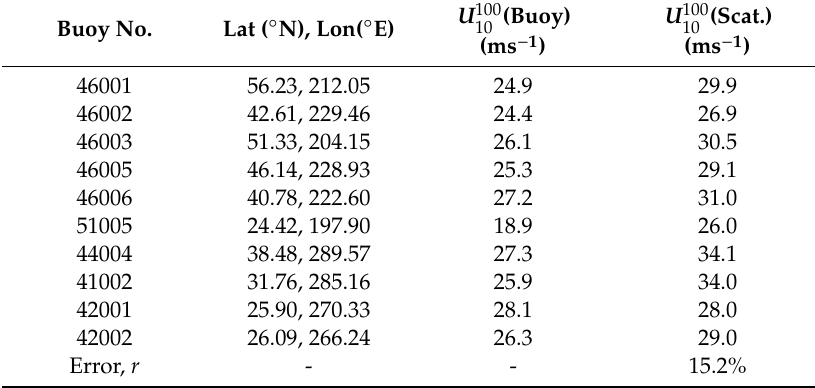
Table 1. Comparison of values of 100-year return period wind speed calculated using a PoT analysis for both scatterometer and NDBC deep-water